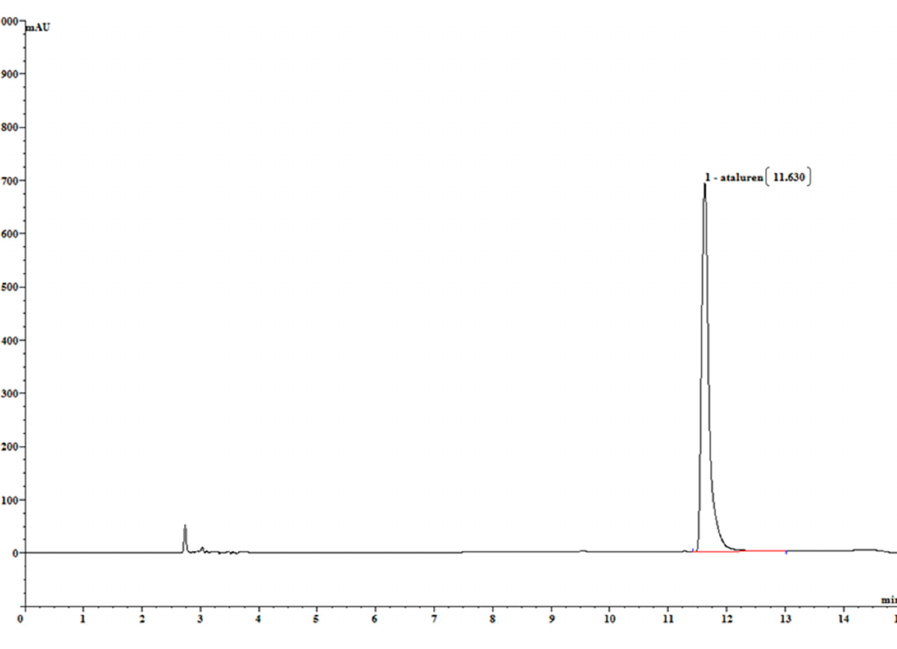
Figure 1. Reference chromatogram of ataluren at 276 nm in the oily solution. The chromatographic method used was found linear for concentrations ranging from 50 to 90 µg/mL. The calculated regression parameters are given in Table 1 and are within the linearity acceptance criteria. An average regression equation was y = 2.074 (± 0.017) x + 10.250 (± 1.271), where x is the ataluren concentration, and y is the surface area, and the average determination coefficient R 2 of three calibration curves was 0.9995. No matrix ef- fect was detected.